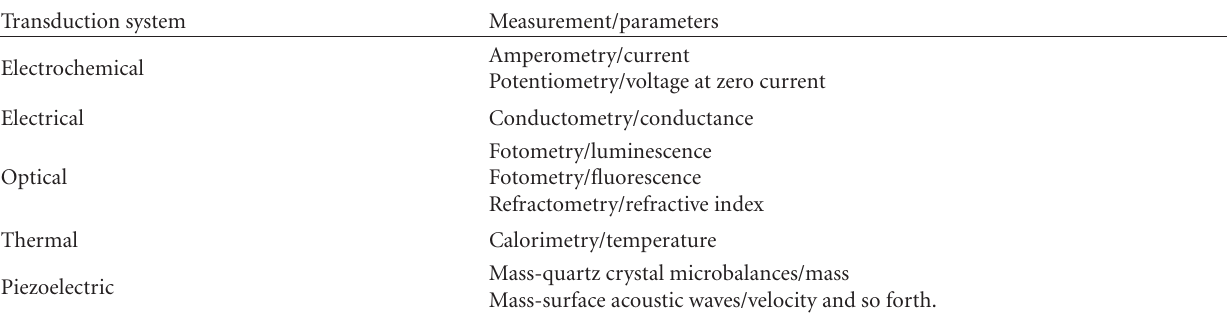
Table 1: Principal transduction systems used in